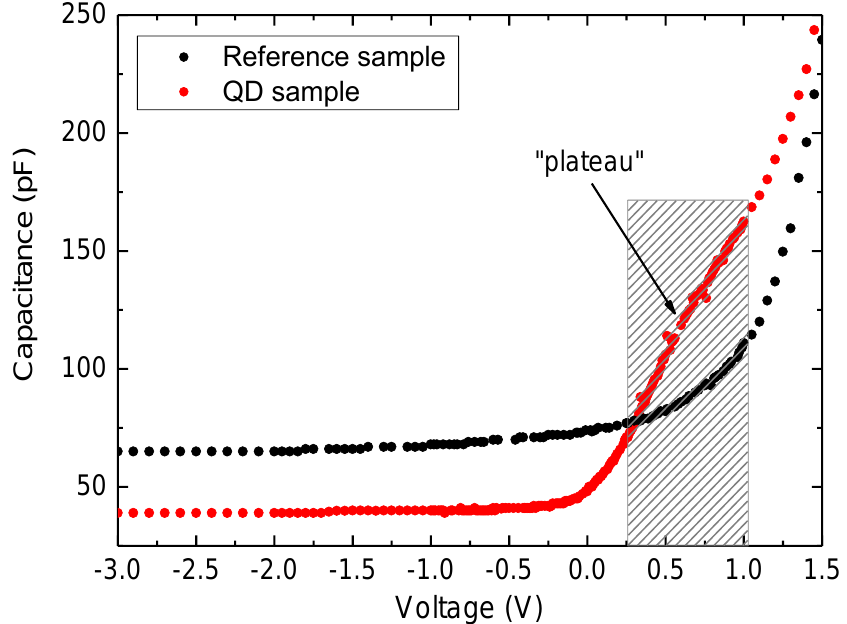
Figure 2. Capacitance-voltage ( C-V ) characteristics taken at 300 K for the QD (red circles) and reference samples (black circles).